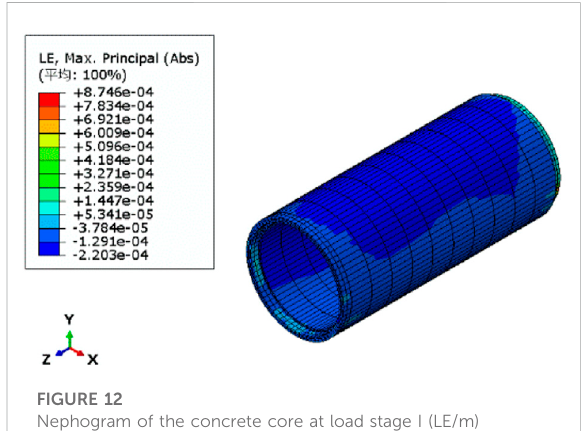
FIGURE 12 Nephogram of the concrete core at load stage I (LE/m)